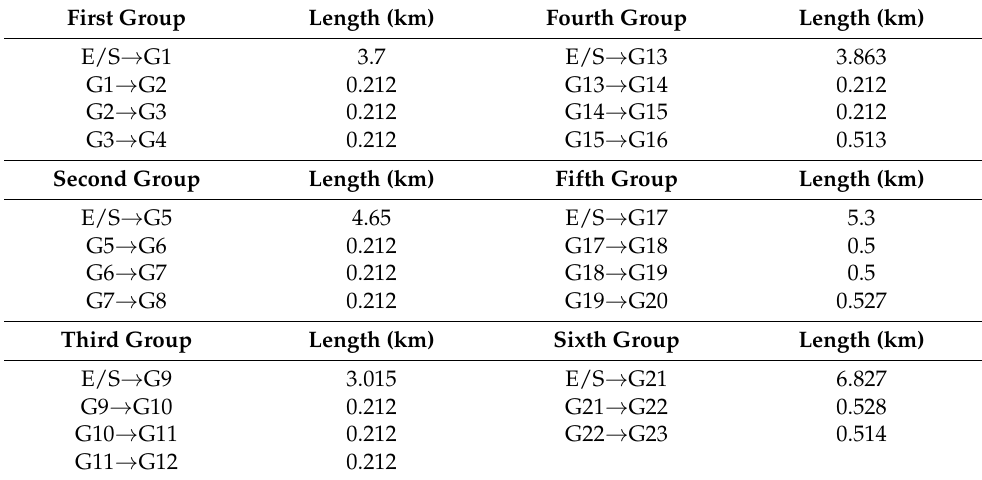
Table 1. Transmission line length in the wind power generation station at Changhua Coastal Indus- trial Park, Taiwan.